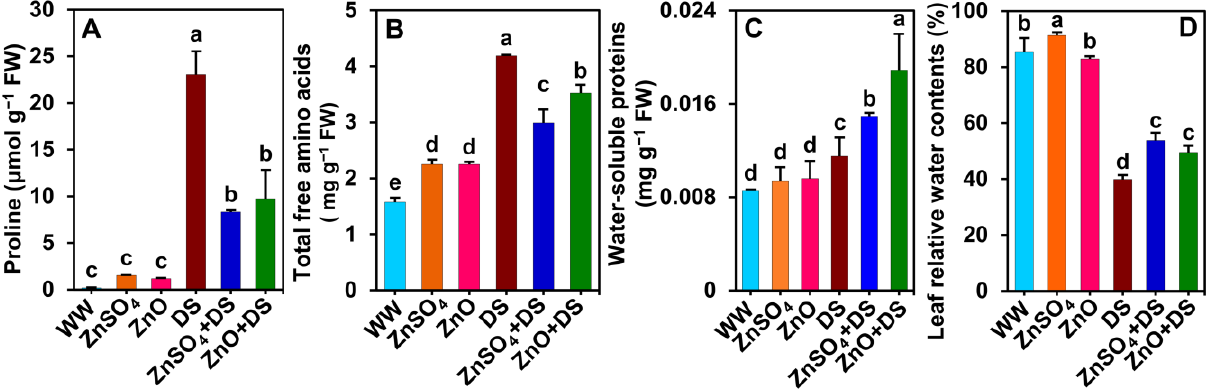
Figure 6. Effect of separately applied ZnSO 4 (1.0 g Kg −1 soil) and ZnO (1.0 g Kg −1 soil) on the level of ( A ) proline, ( B ) total free amino acids, and ( C ) water-soluble proteins, as well as on the ( D ) relative water contents in the leaves of cotton plants that were subjected to water deprivation-induced drought stress for 6 days. The means and standard deviations ( n = 3) are displayed as bars. Significant changes ( p < 0.05) among the treatments are denoted by different letters (a – e) above the bars as calculated using the least significant difference test. Here, the treatments are well-watered plants (WW), ZnSO 4 -supplemented well-watered plants (ZnSO 4 ), ZnO-supplemented well-watered plants (ZnO), drought-stressed plants (DS), ZnSO 4 -supplemented drought-stressed plants (ZnSO 4 + DS), and ZnO-supplemented drought-stressed plants (ZnO + DS). FW, fresh weight.